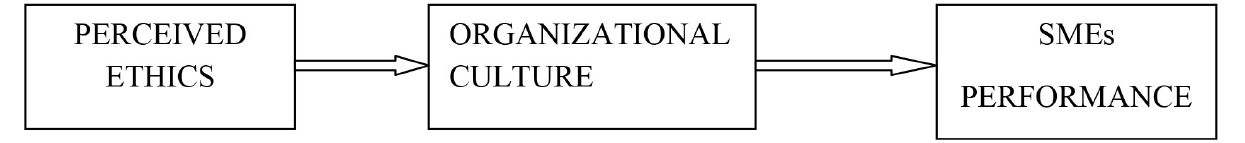
Figure 1. Research